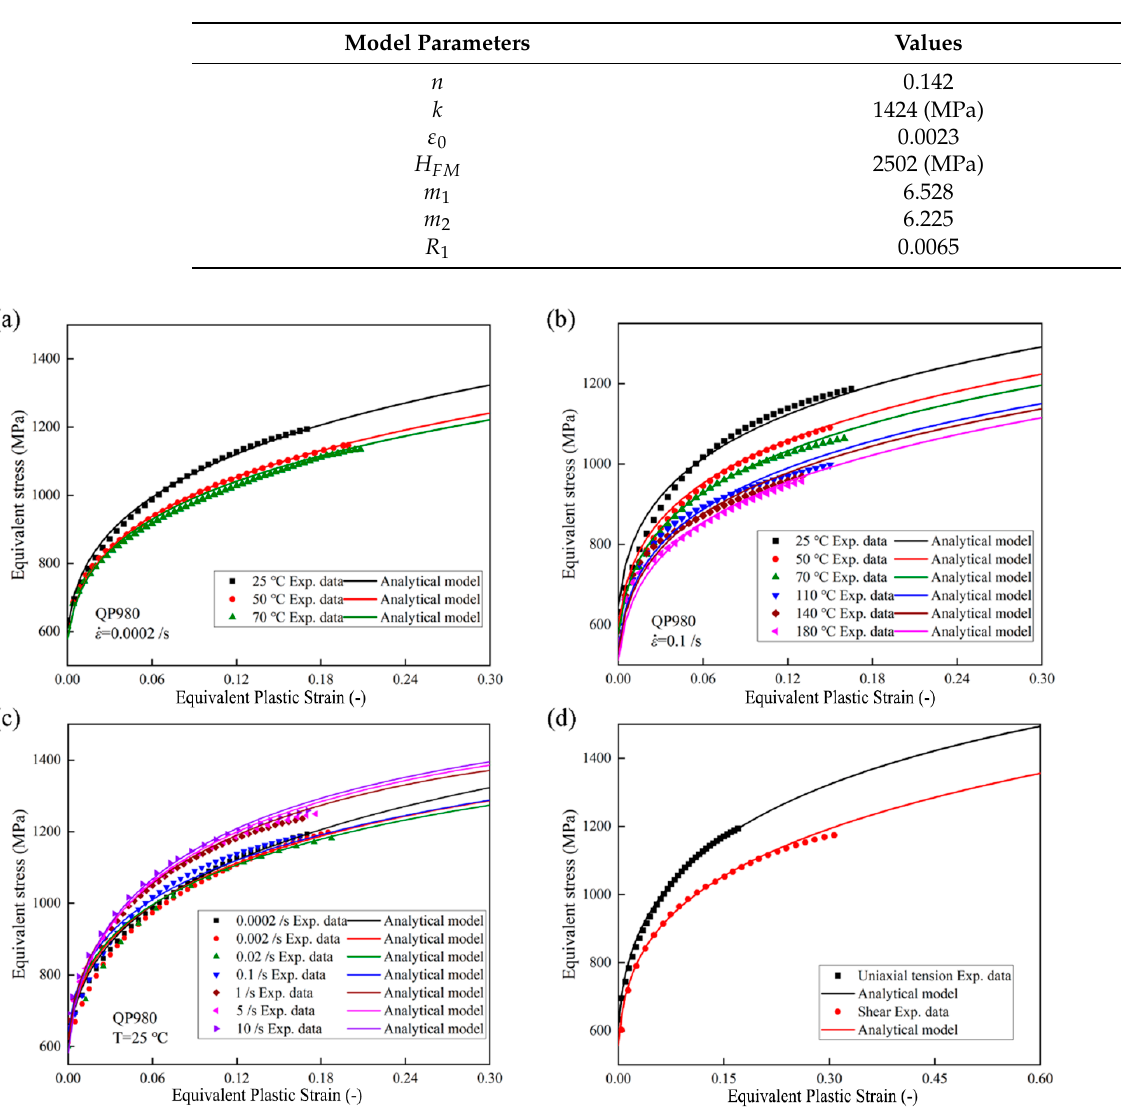
Figure 7. Analytical predictions and experimental data of equivalent stress-strain curves at various strain rates and temperature: ( a ) equivalent stress-strain curves at various temperature and a fixed quasi-static strain rates ( 𝜀(cid:4662) = 0.0002/s); ( b ) equivalent stress-strain curves at various temperature and a fixed medium strain rates ( . ε = 0.1/s); ( c ) equivalent stress-strain curves at various strain rate and a fixed temperature (T = 25 ◦ C); ( d ) equivalent stress-strain curves under tension and shear stress